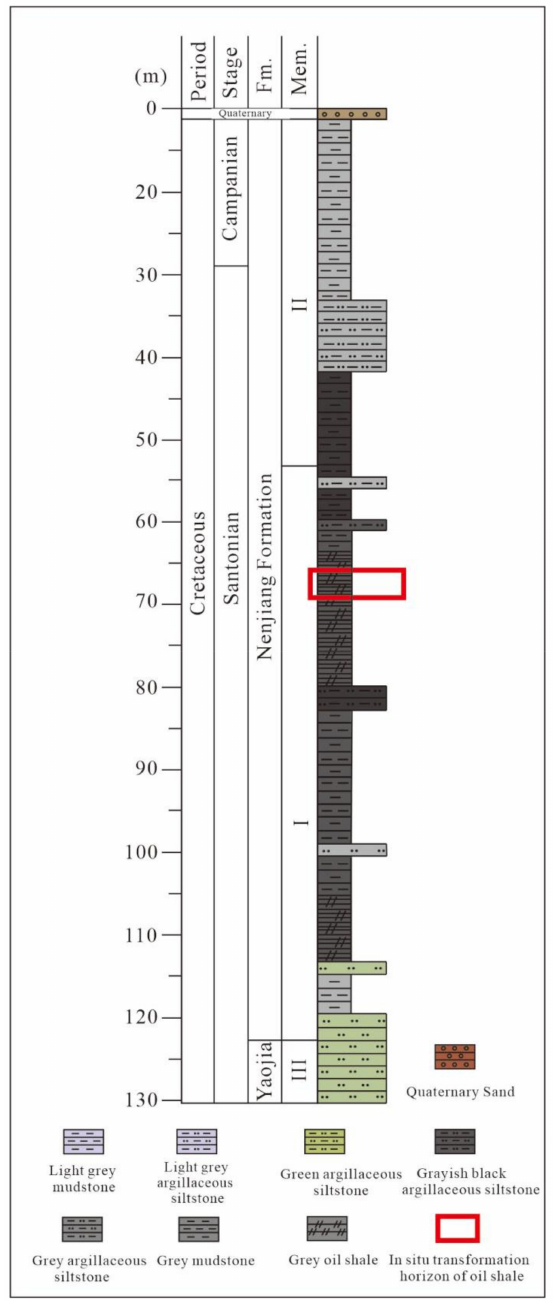
Figure 3. Stratigraphic log of the Nongan oil